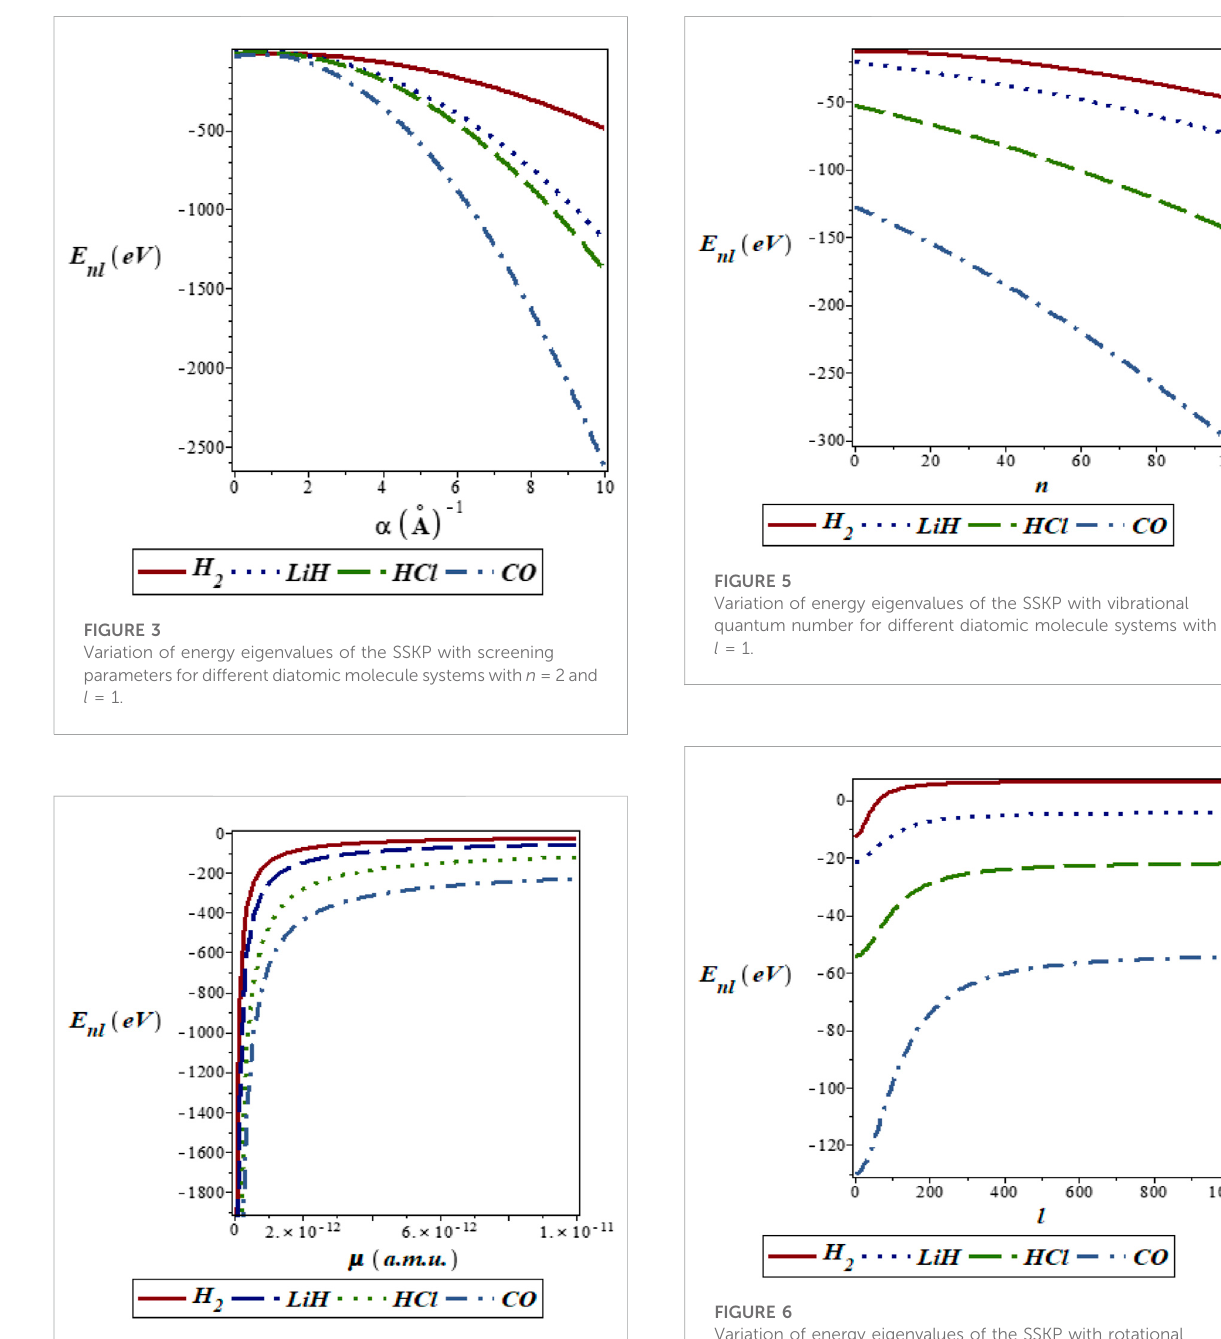
FIGURE 6 Variation of energy eigenvalues of the SSKP with rotational quantum number for different diatomic molecule systems with n =